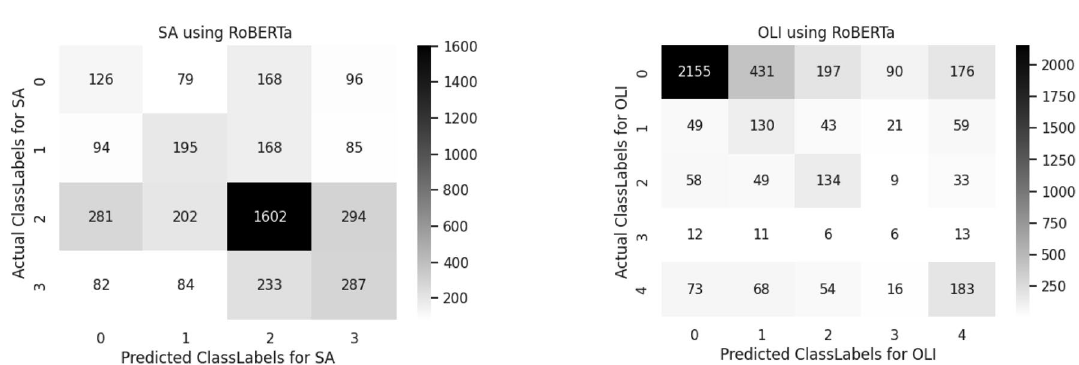
Figure 6. Confusion matrix of Bi-LSTM for sentiment analysis and offensive language identification.